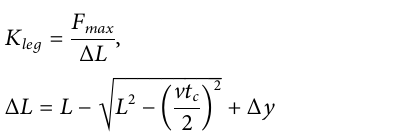
Frontiers in Physiology |